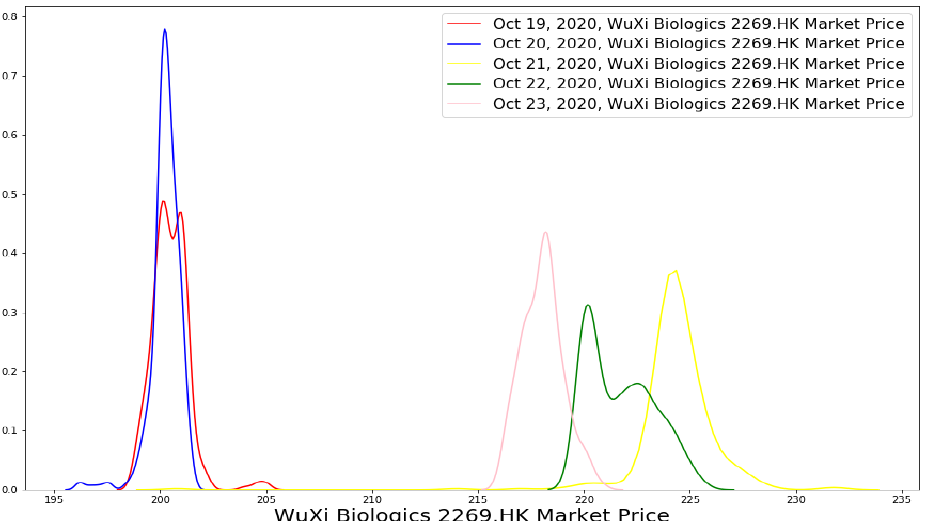
Figure 2. WuXi Biologics is a listed company on the Hong Kong Stock Exchange, one of HSI Composites. For a consecutive trading week, the prices at minute level intervals are plotted in six distributions (the total area under the curve integrates to one with each date as one distribution). The probability density (Y-axis) is the per unit on the prices (X-axis). There exist statistics properties like kurtosis and skewness, mean and standard